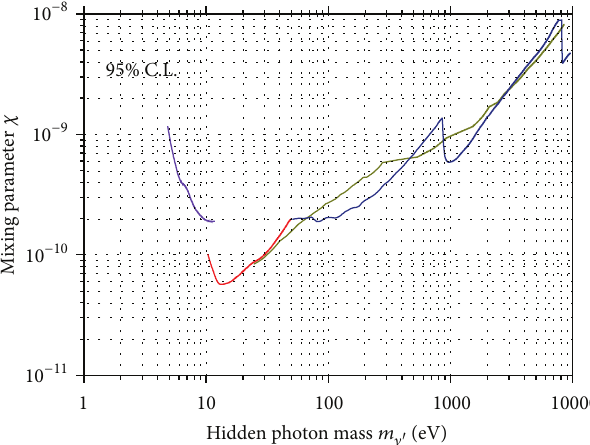
Figure 8: The limit for a mixing constant 𝜒